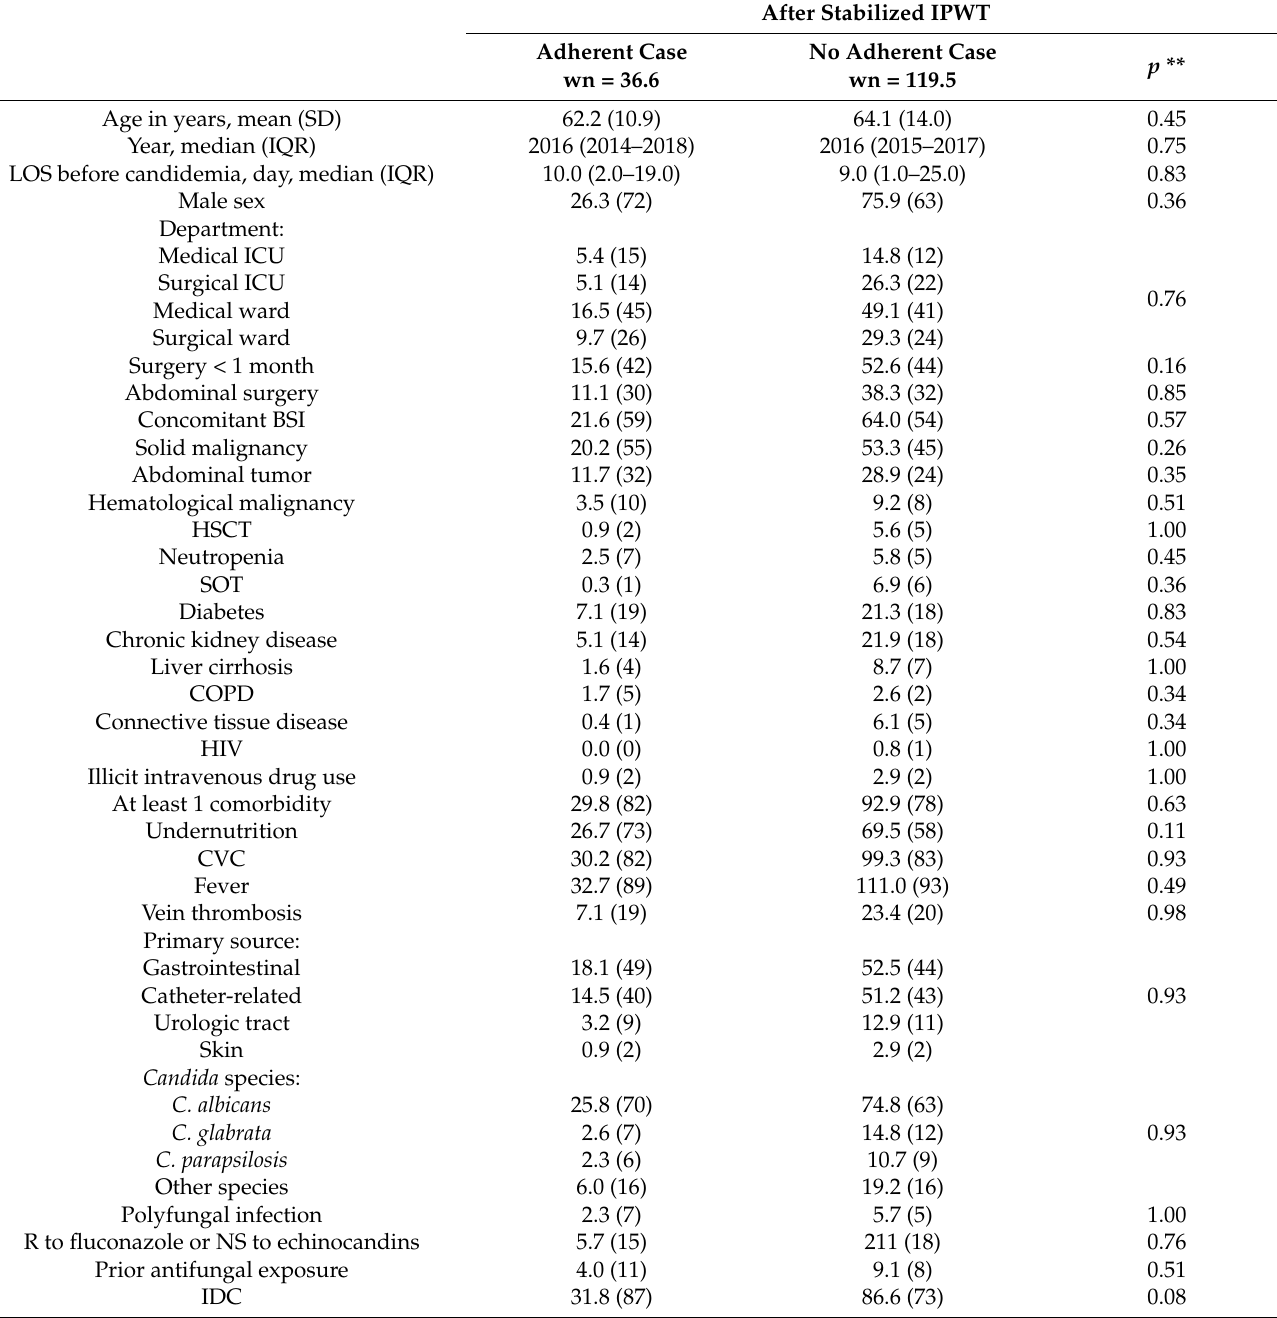
Table 3. Weighted pseudo-population of the cohort after stabilized